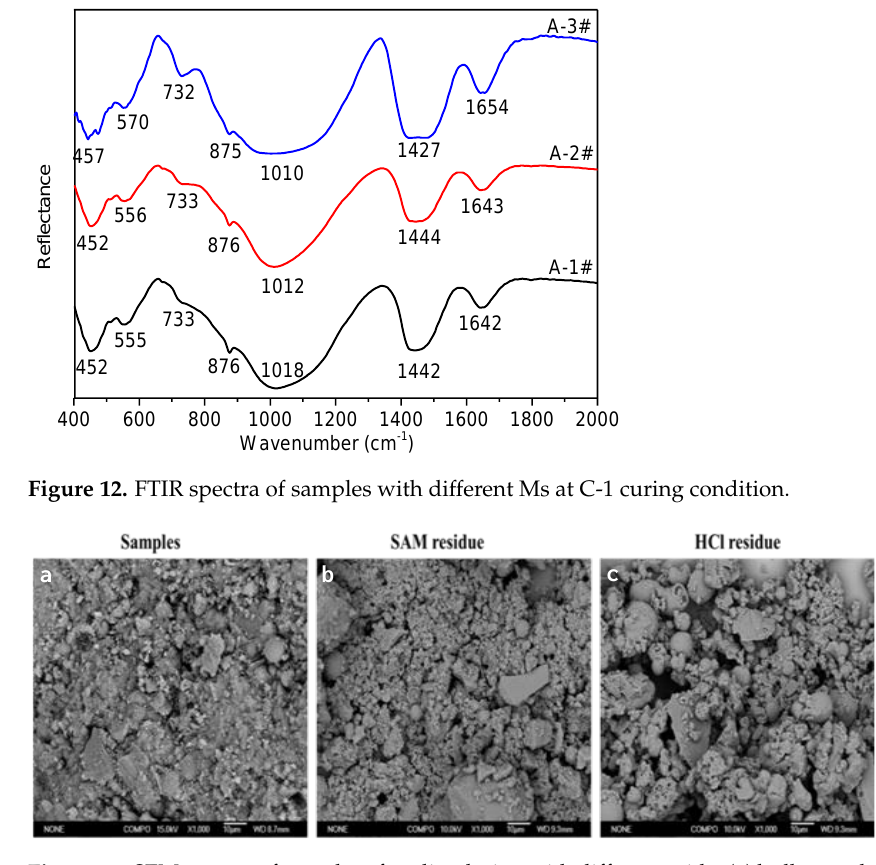
Figure 13. SEM spectra of samples after dissolution with different acids: ( a ) bulk samples, ( b ) samples after SAM, ( c ) samples after HCl.